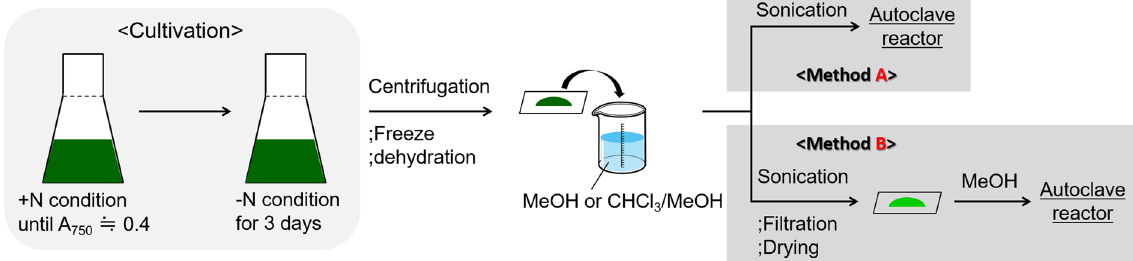
Figure 3. Method for the preparation of algal residue.